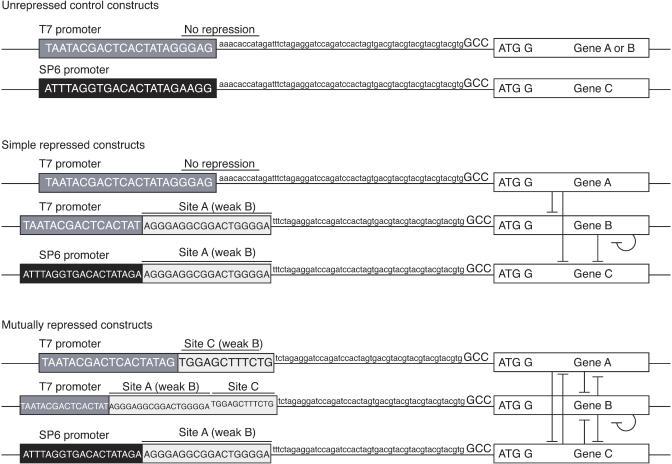
Map of the Constructs Used in This StudyThe repressor binding sites overlap with T7 or SP6 promoters and vary between constructs. In this way, it is possible to alter the connectivity of the repressive interactions by the products of genes A, B, and C. Repressive interactions are denoted by T-bars. The start codon of each gene is in Kozak context and is denoted by “GCC ATG G.”